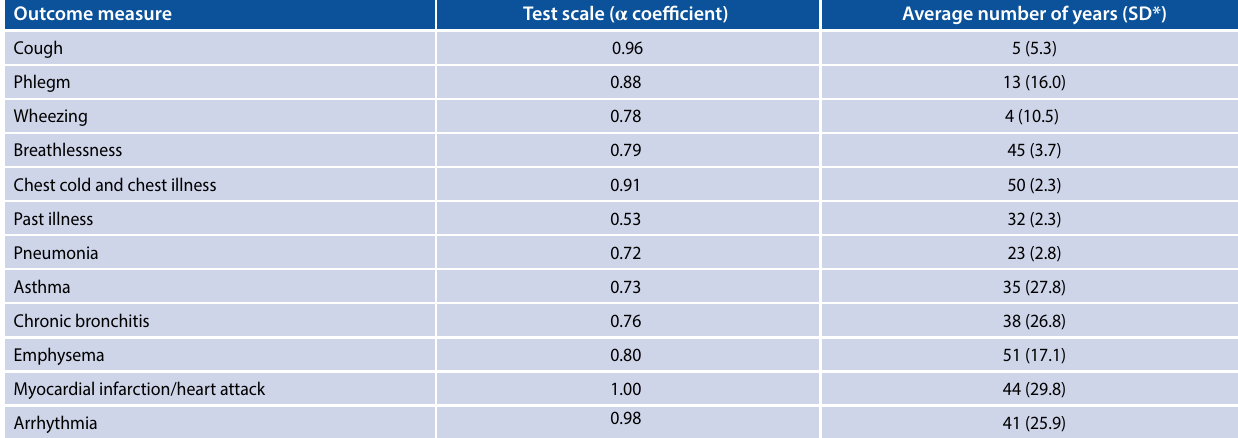
Note: *SD – Standard